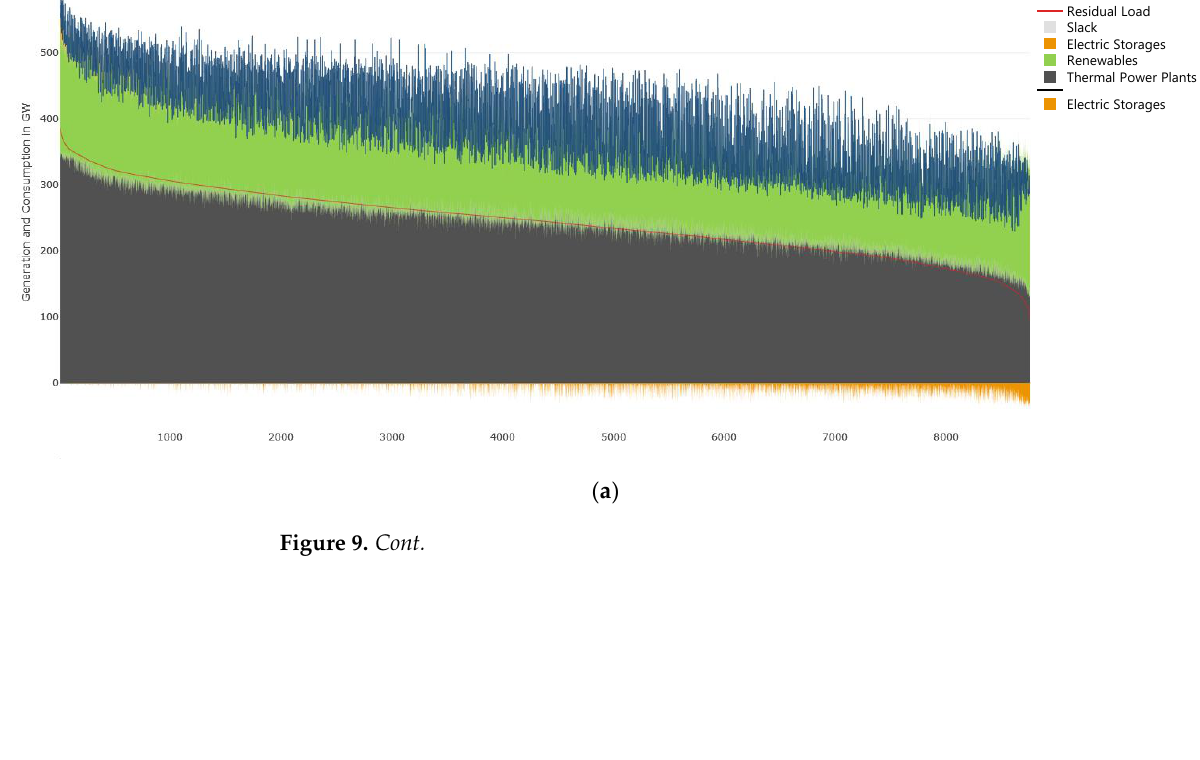
Table 1. FLH of thermal power plants per year in solidEU.